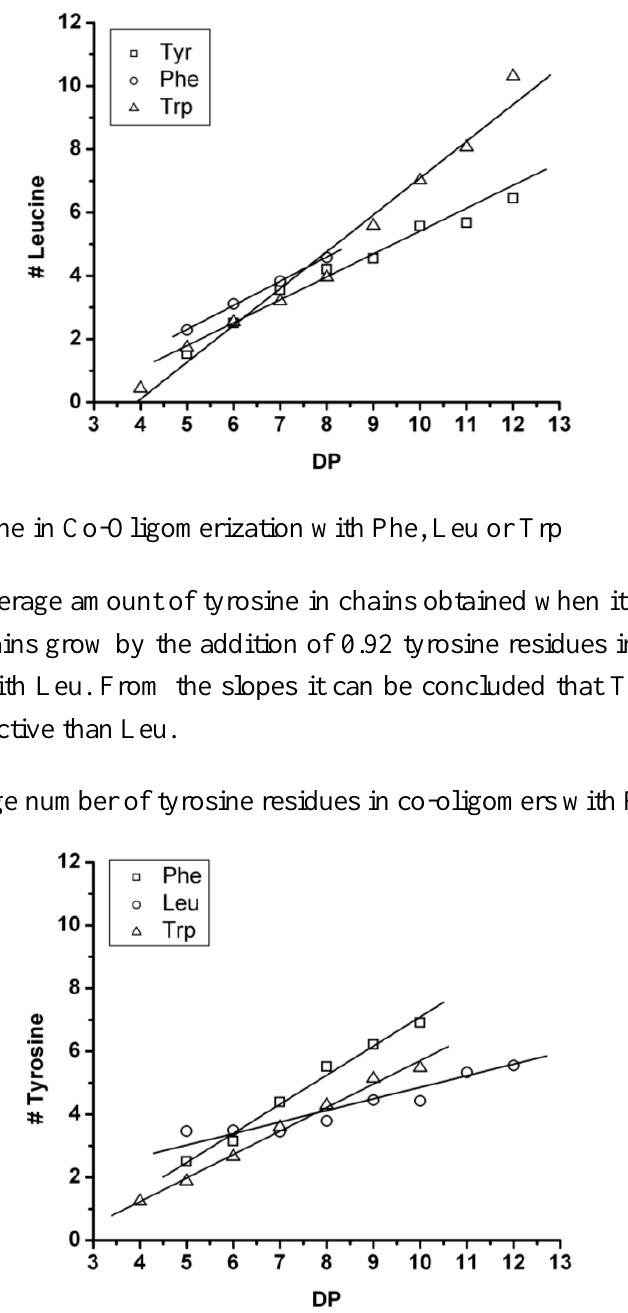
Figure 16. Average number of leucine residues in co-oligomers with Tyr, Phe or Trp.